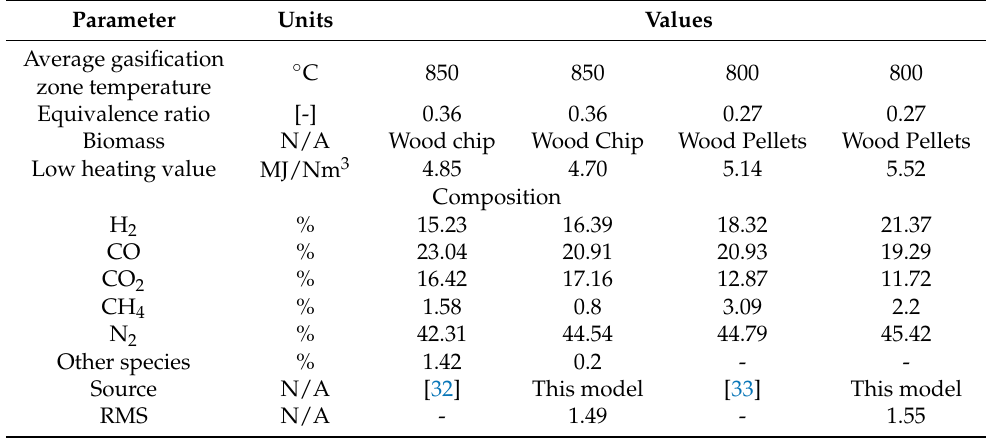
Table 4. Validation of the downdraft gasifier model